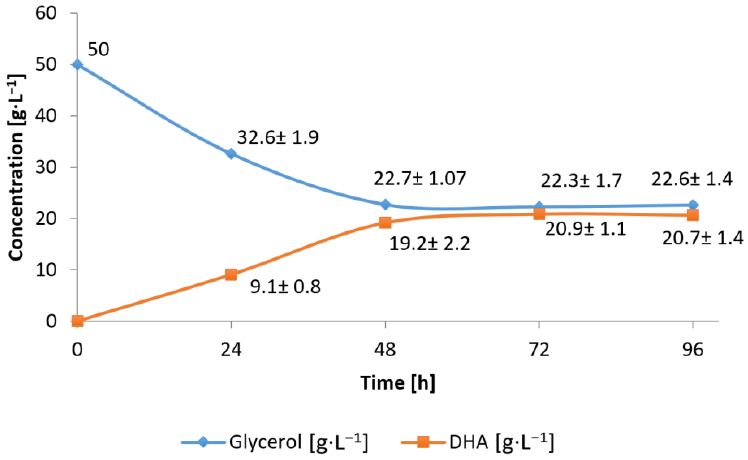
Figure 4. Time profiles of glycerol conversion and DHA formation during conversion of 50 g · L − 1 of a waste glycerol fraction with free G. oxydans cells.